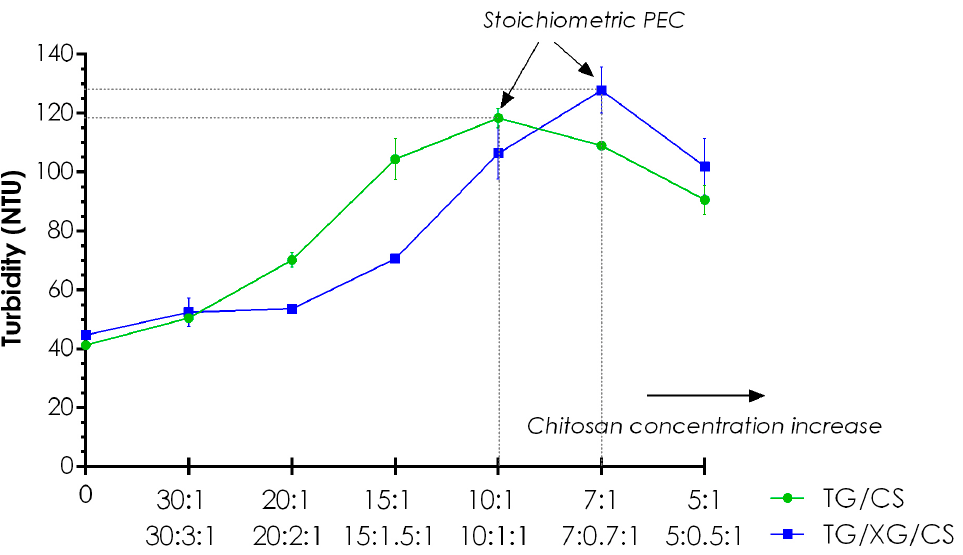
Figure 6. The measured turbidity values of tragacanth gum (TG)/chitosan (CS) and TG/xanthan gum (XG)/CS formulations with regard to various polyanion/polycation ratios.